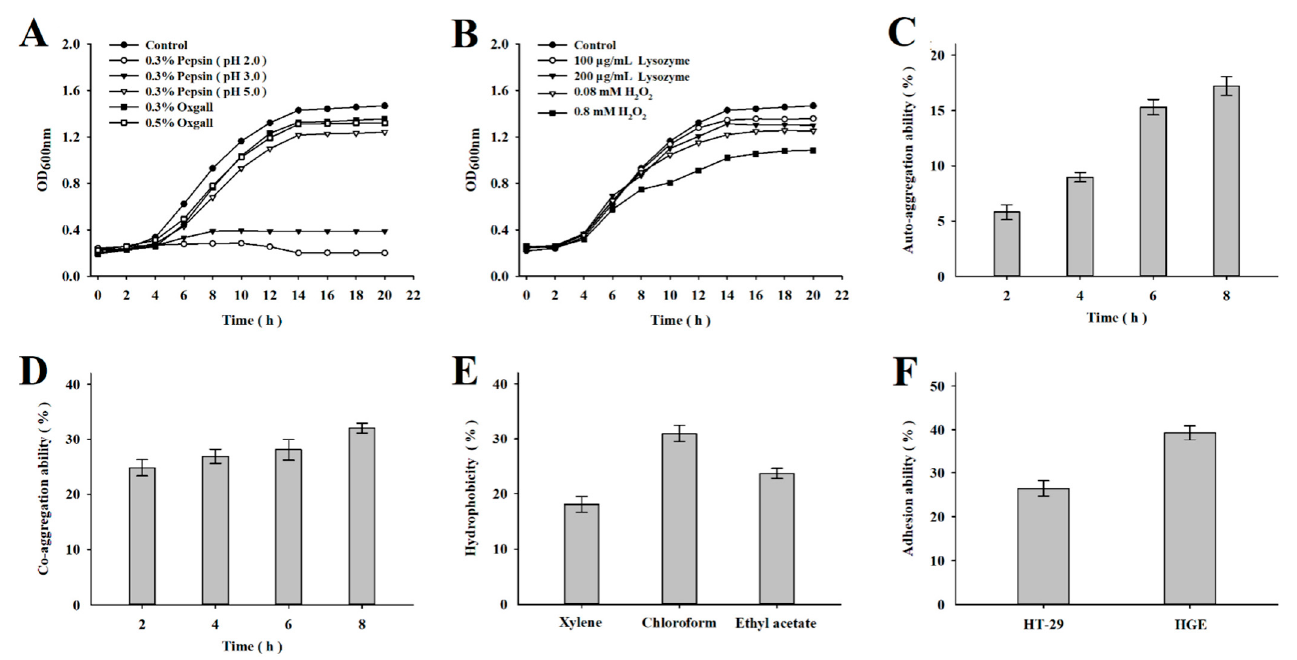
Figure 1. Probiotic characteristics of L. mesenteroides LVBH107. ( A ) Growth curves of L. mesenteroides LVBH107 exposed to MRS broth contained 0.3% pepsin (pH 2.0, pH 3.0, pH 5.0) and bovine bile salt (0.3%, 0.5%) for 20 h. ( B ) Growth curves of L. mesenteroides LVBH107 exposed to MRS broth contained lysozyme (100 μ g/mL, 200 μ g/mL) and H 2 O 2 (0.08 mM, 0.8 mM) for 20 h. ( C ) Auto-aggregation ability of L. mesenteroides LVBH107. ( D ) Co-aggregation ability of L. mesenteroides LVBH107. ( E ) Surface hydrophobicity of L. mesenteroides LVBH107. ( F ) Adhesion ability of L. mesenteroides LVBH107 to HT-29 and HGE.